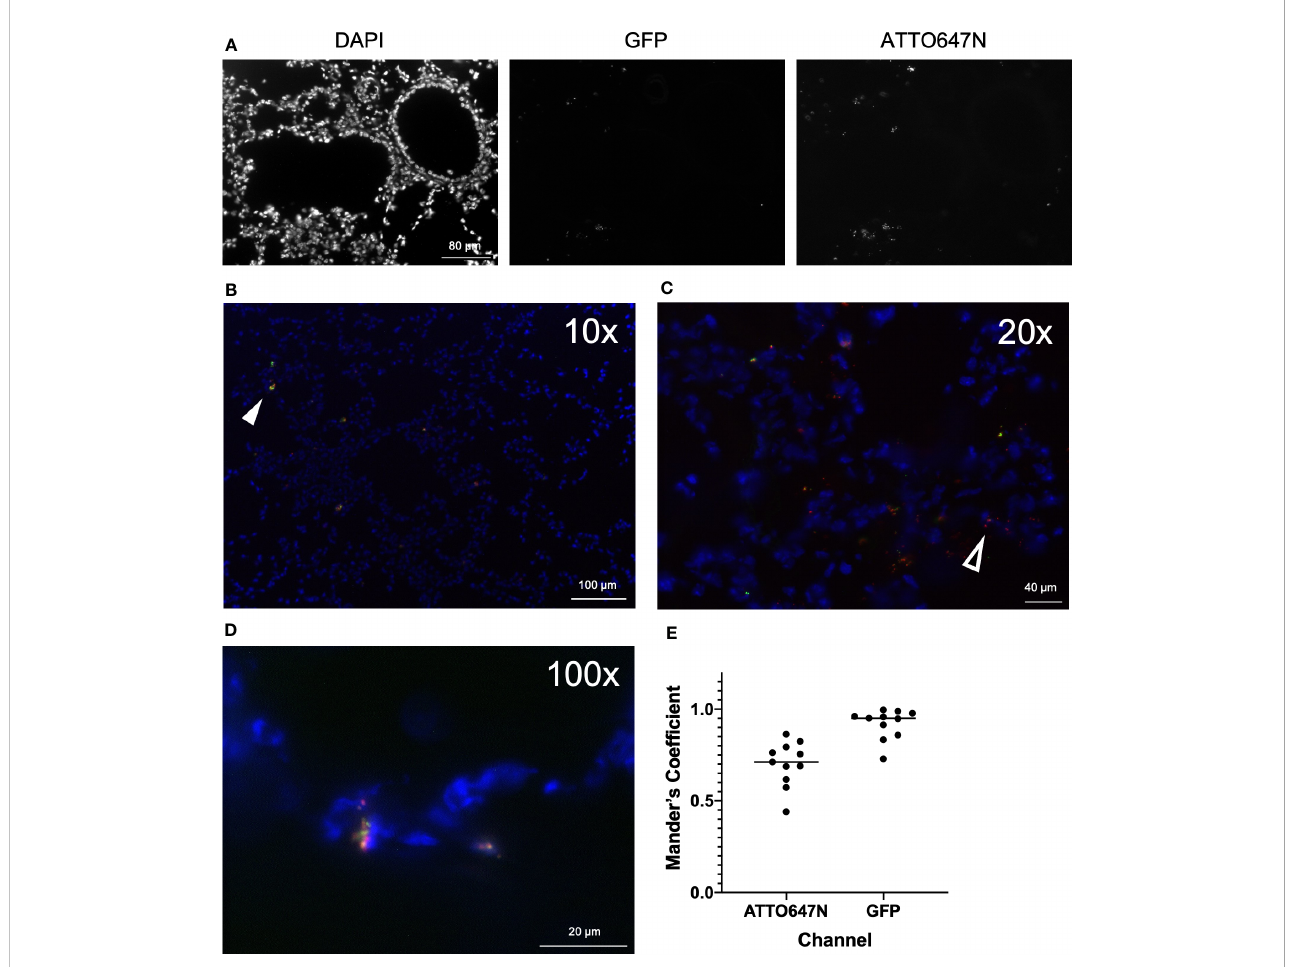
FIGURE 6 Imaging of airways post-infection with bi- fl uorescent S. aureus . (A) Frozen lung sections were prepared from WT mice (n=3) 12 hours post-infection with bi- fl uorescent S. aureus to visualize the infection in the tissue. Unmerged DAPI, GFP, and ATTO647N images show localization of airway cells, viable S. aureus , and total S aureus , respectively (20x). Merged images at (B) 10x (C) 20x and (D) 100x visualize both killed (red, open arrowhead) and viable (yellow, arrowhead) S. aureus within the tissue. (E) Colocalization analysis of GFP and ATTO647N images (n=11) show high overlap of the GFP signal with the ATTO647N signal (Mander ’ s Coef fi cient ~1) and incomplete overlap of the ATTO647N signal with the GFP signal (Mander ’ s Coef fi cient